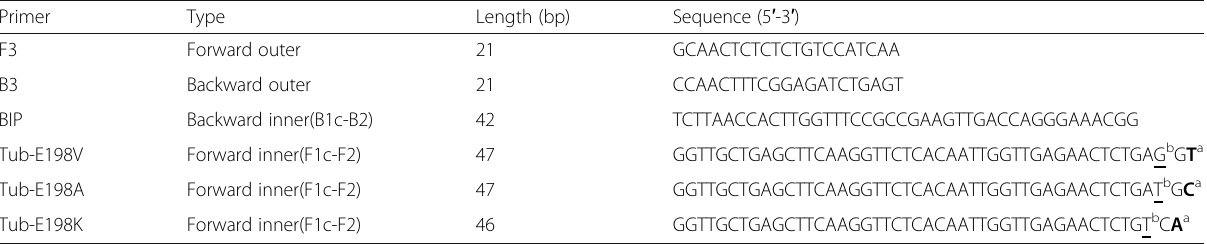
Sensitivity of LAMP and conventional PCR The sensitivity of LAMP and conventional PCR was in- vestigated using Tub-E198V primer set and ten-fold serial dilutions of plasmid pMD18-TubA. When the concentration of plasmid reached 2 × 10 5 copies/ μ L, the ladder-like product was observed by electrophoresis, and the color change of SYBR Green I also occurred Table 1 Design of LAMP primers for detection of the E198K/A/V mutations of TUB2 in Botrytis cinerea